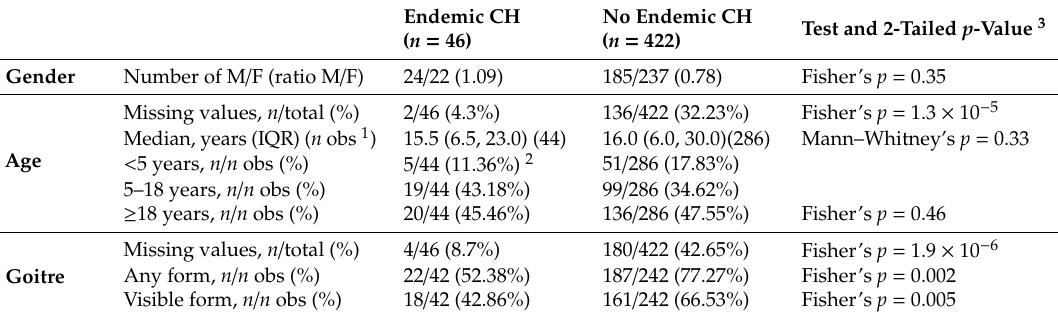
Table 2. Characteristics of subjects with and without endemic CH.